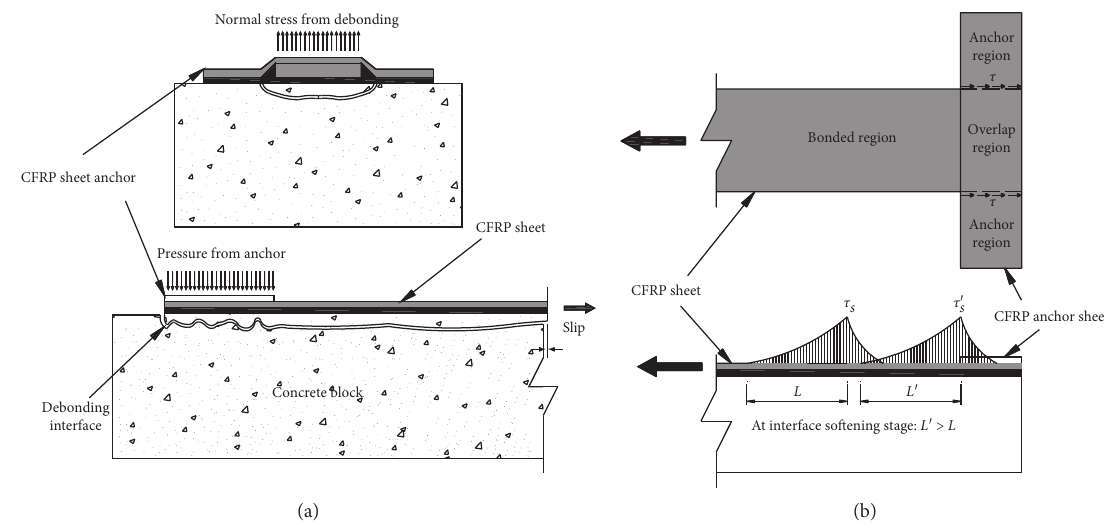
Figure 4: Anchoring mechanism of FRP sheet-anchorage system. (a) Sketch of anchoring mechanism. (b) Increased friction between two debonded